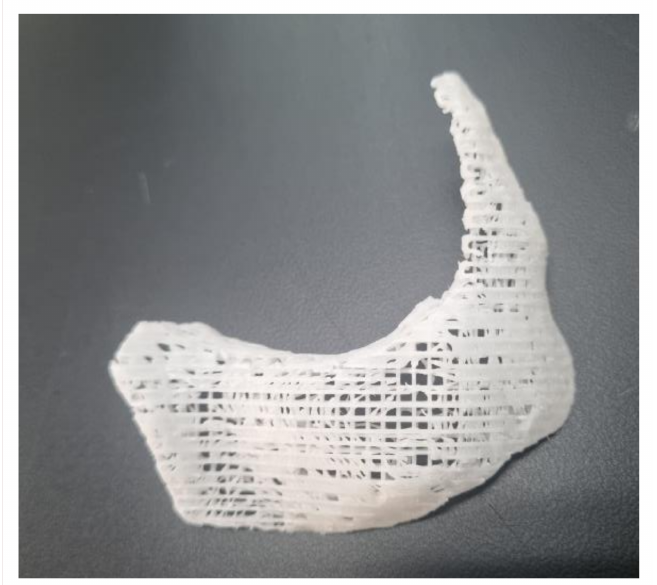
Figure 2. Photograph of 3D printed PCL/ β -TCP scaffold with line with 500 µ m, and 50% of